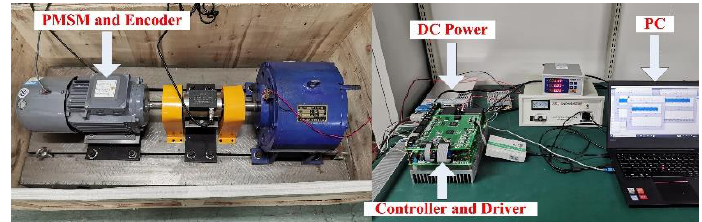
Figure 14. Photograph of the experimental platform.